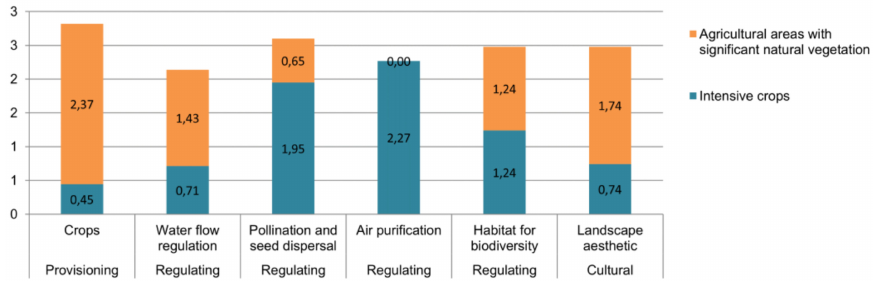
Figure 5. List of the six most ranked ES by experts on a Likert scale from 0 to